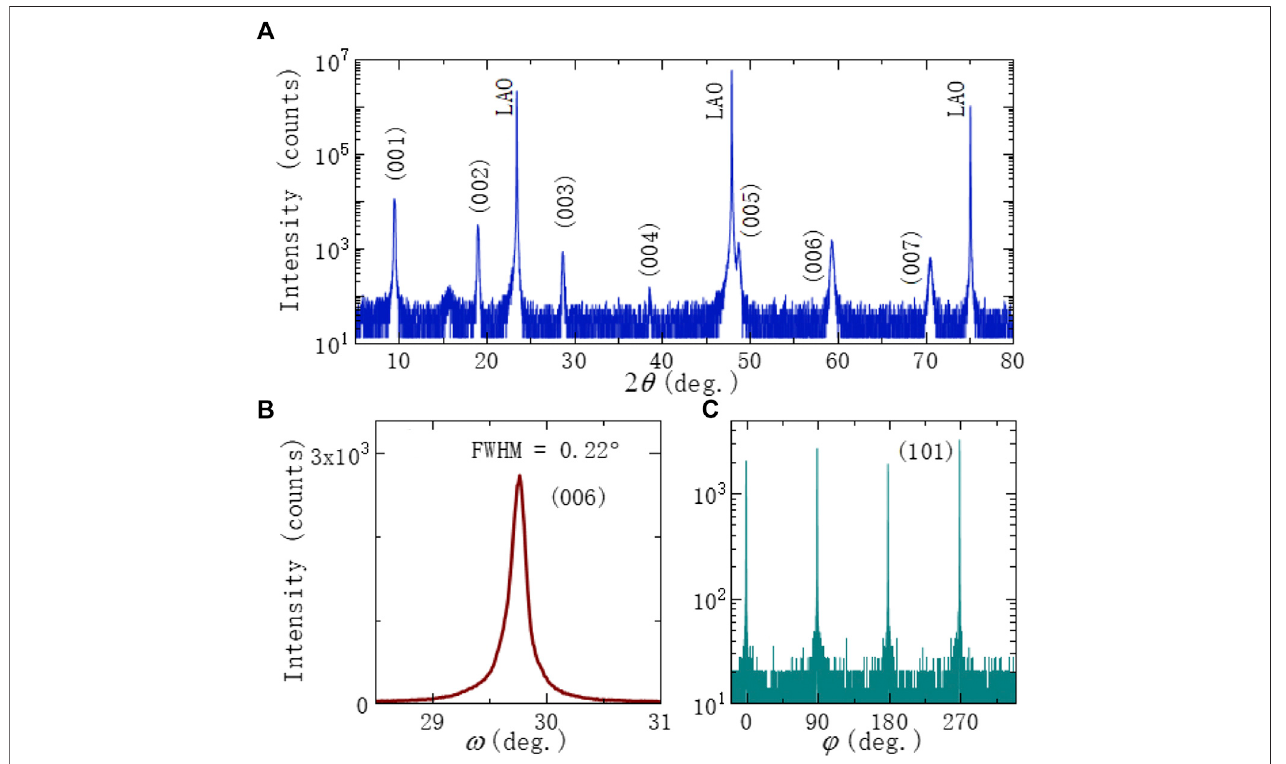
FIGURE 9| XRD characterizations ofthe (Li,Fe)OHFeSe fi lm on the LaAlO 3 (LAO) substrate. (A) The two theta scan detects only (00 l ) peaks. (B) The rocking curve of (006) re fl ection with an FWHM of 0.22 ° . (C) The ϕ -scan of the (101) plane. The 4-fold symmetry reveals an excellent epitaxial growth [16].